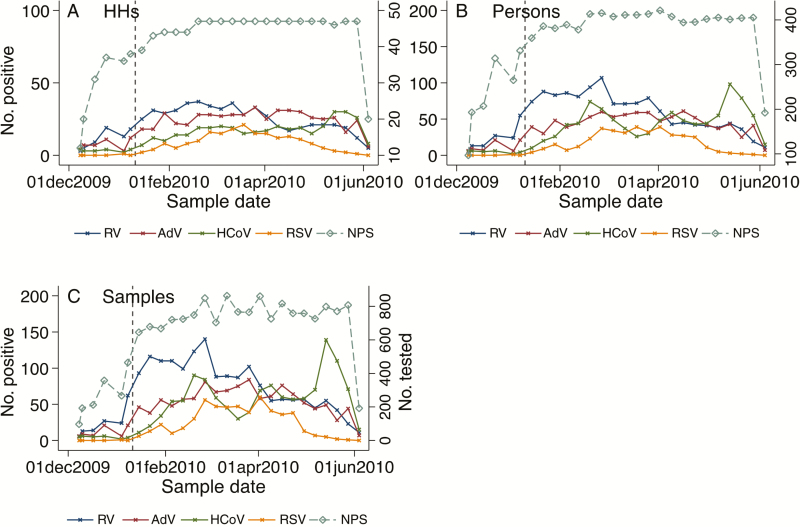
Number of nasopharyngeal swabs tested from the 47 households and viruses detected in households (A), persons (B), and samples per week (C) over the study period. The vertical dashed line denotes the start of the main study period, 10 January 2010. Abbreviations: AdV, adenovirus; HCoV, human coronavirus; HH, household; NPS, nasopharyngeal swab; RSV, respiratory syncytial virus; RV, rhinovirus.